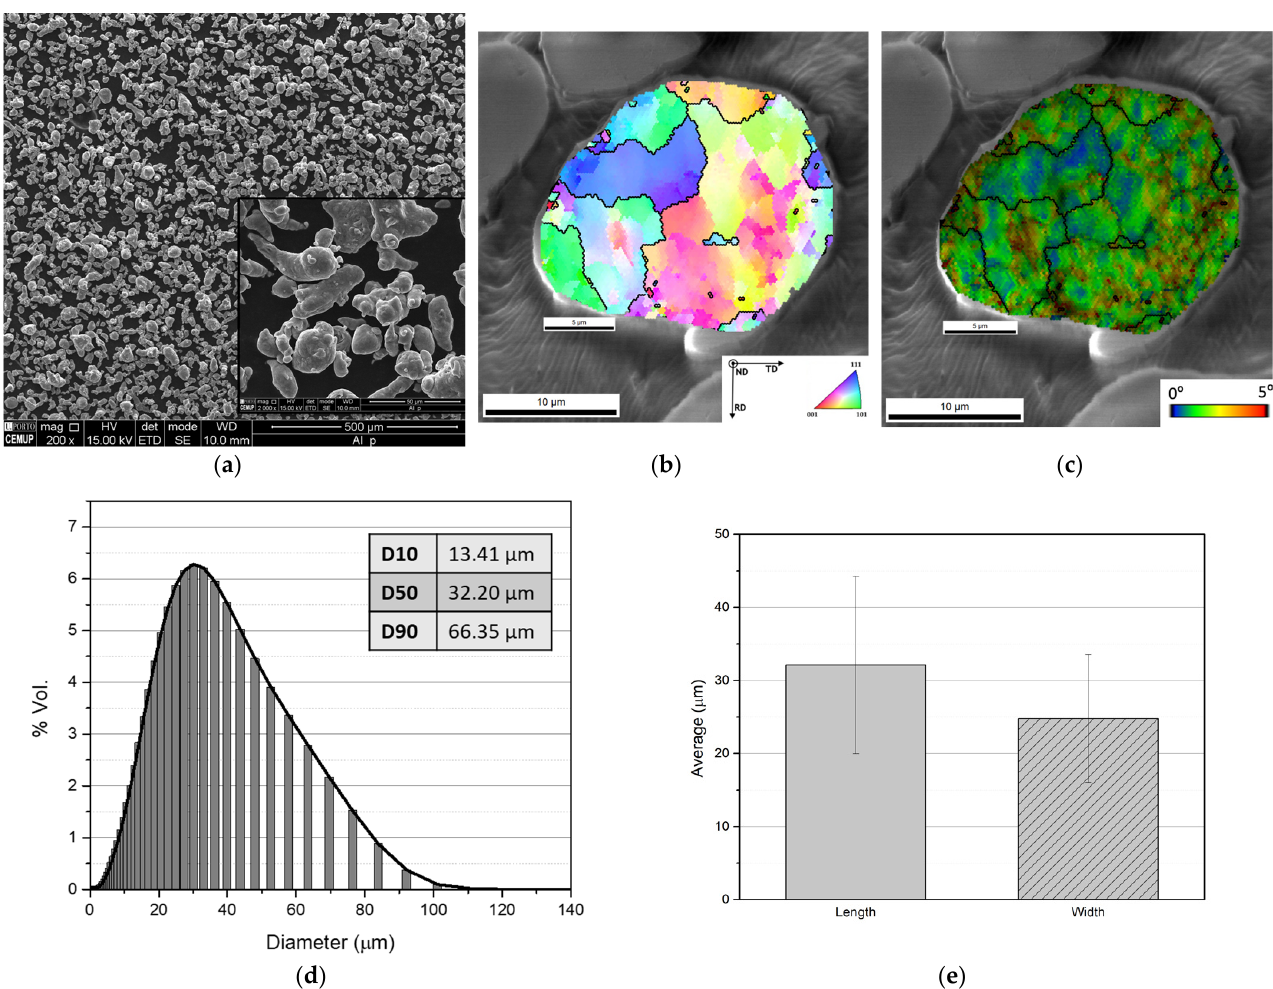
Figure 3. Full analysis of the Al powder as received showing ( a ) Scanning electron microscopy (SEM) image of Al powders, ( b , c ) exemplifying particle analyzed with electron backscatter diffraction (EBSD) with an ( a ) inverse pole figure map and ( b ) Kernel average misorientation map, ( d ) size distribution and ( e ) average values of length and width of the particles.